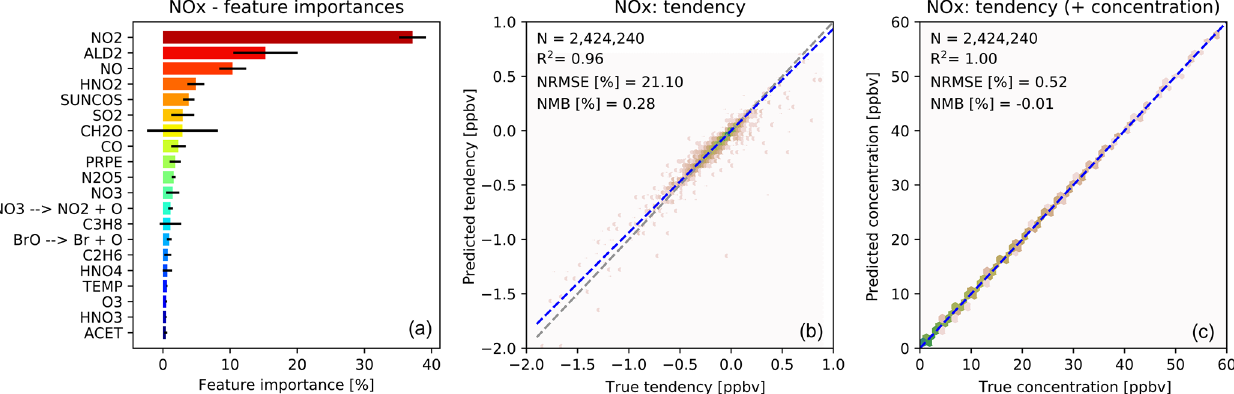
Figure 4. As Fig. 3 but for NO x (NO + NO 2